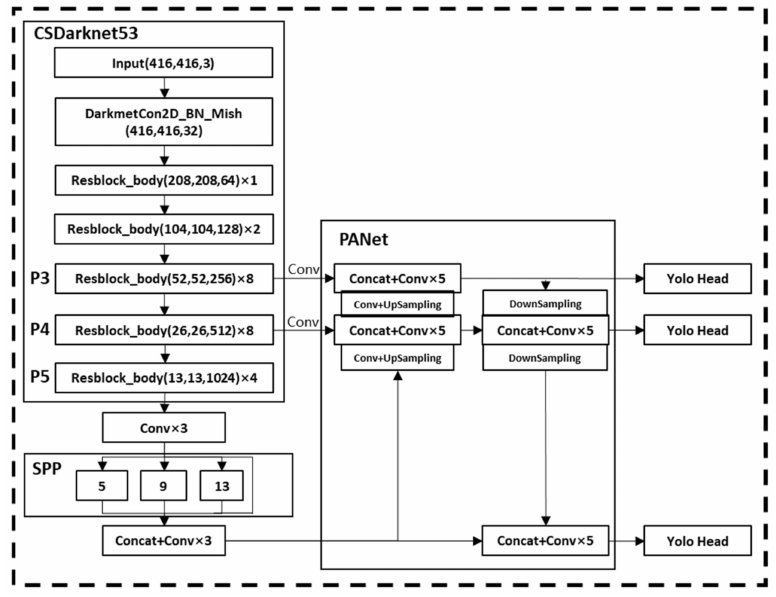
Figure 1. YOLOv4 network